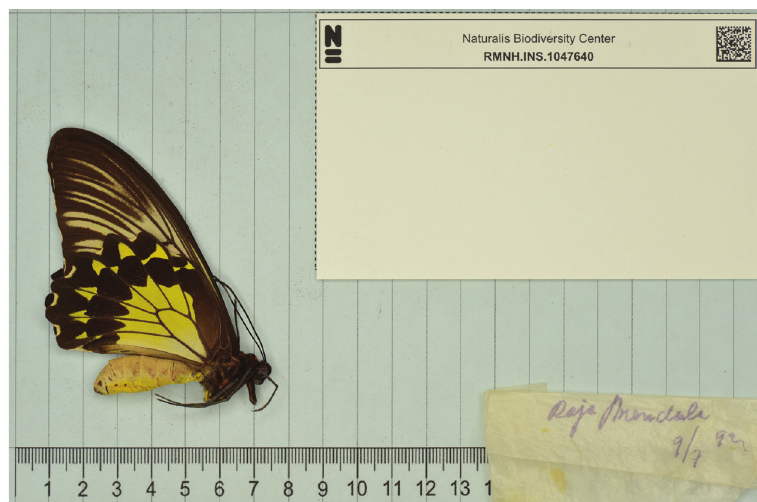
Figure 5. An example of the standardized photographs produced during this project. These are later sent to taxonomic experts for identification and can be used for automated image recognition. They will also be vis - ible online on bioportal.naturalis.nl.